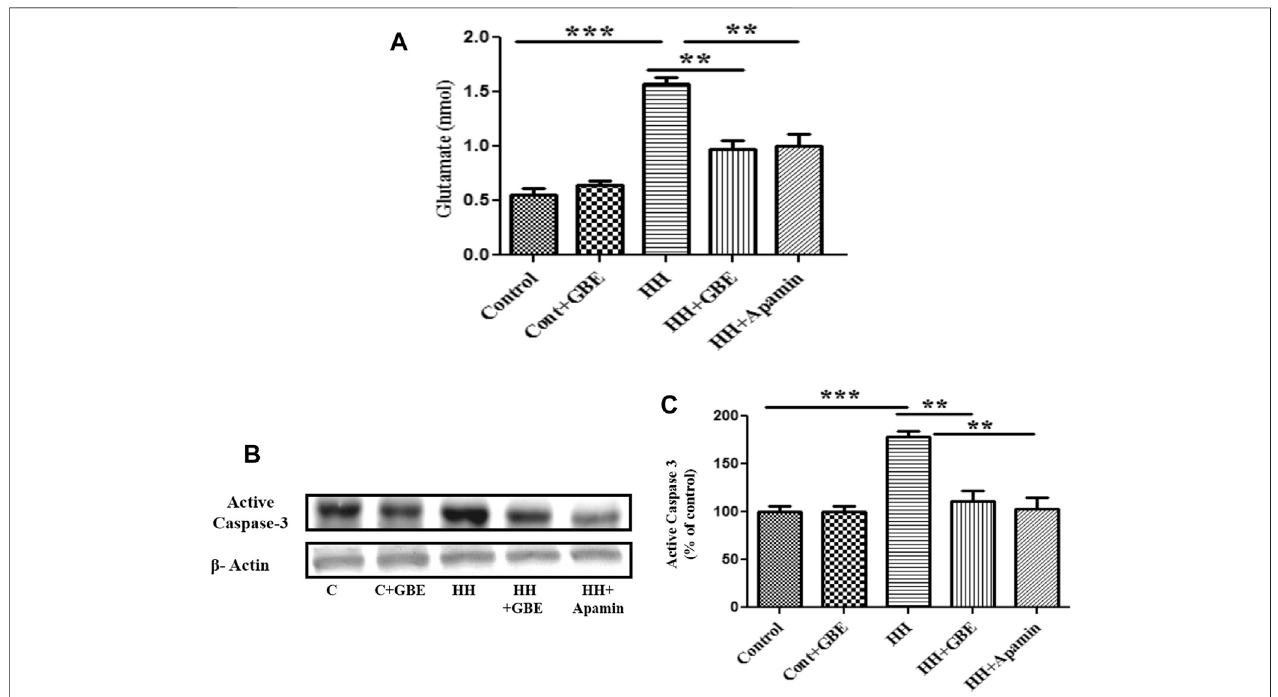
FIGURE 7 | GBE reduces glutamate excitotoxicity and activates caspase-3 expression via SK2 inhibition. The graphic representation shows that the glutamate level increased on the 14th day of HH exposure, and the glutamate level decreased signi fi cantly after GBE treatment. However, compared with the HH group, the SK2 inhibitor,apamin,canalsoreducethetoxicityofglutamate (A) .Immunoblottingshowedthatcomparedwiththecontrol,theexpressionofactivatedcaspase-3increased signi fi cantly after 14 days of exposure to HH, while the GBE and SK2 inhibitor, apamin, signi fi cantly reduces its expression (B) . Densitometry analysis of the activated caspase-3 expression using ImageJ software (C) . One-way ANOVA with the Bonferroni test was used to analyze the data. Data are represented as mean ± SEM. ** p < 0.01 and *** p < 0.001.